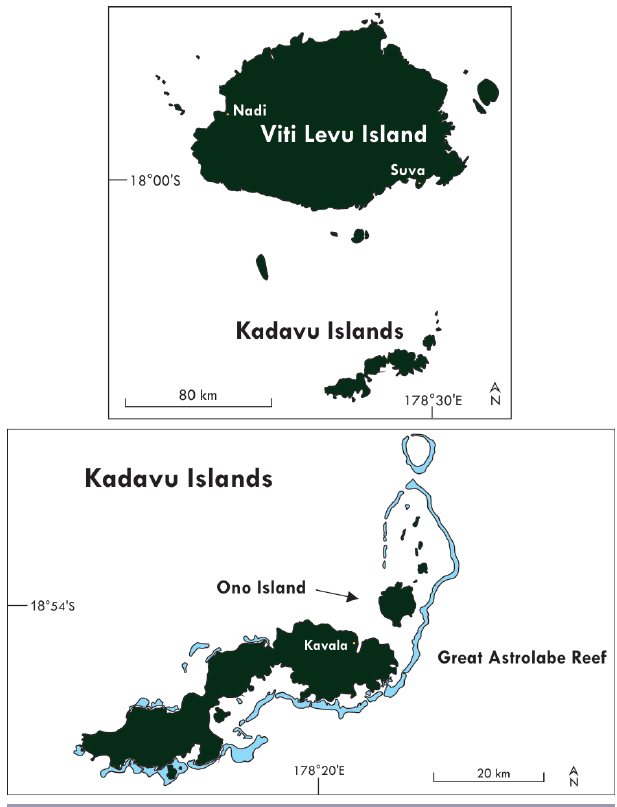
Fig. 3. Map of Viti Levu, Kadavu, and Ono islands,